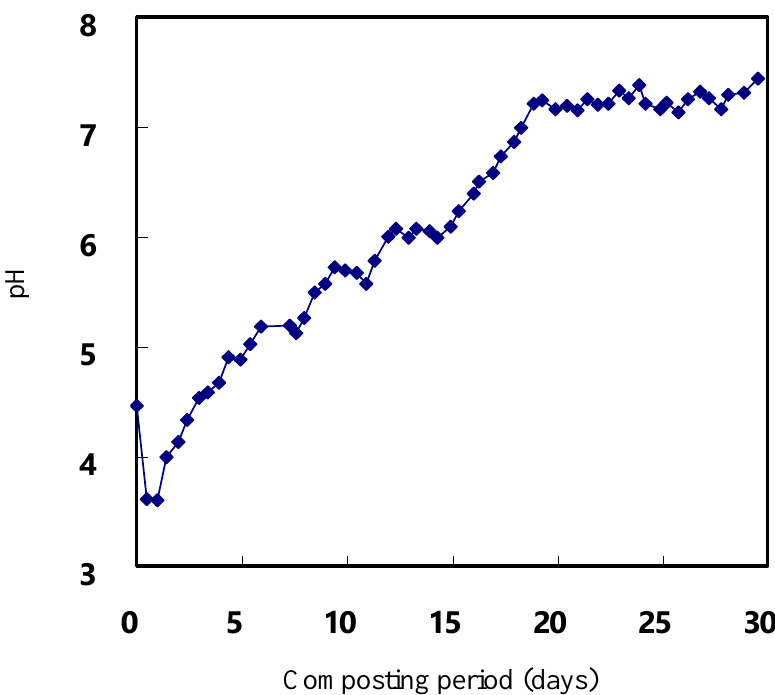
Figure 4. pH variation during the composting period.